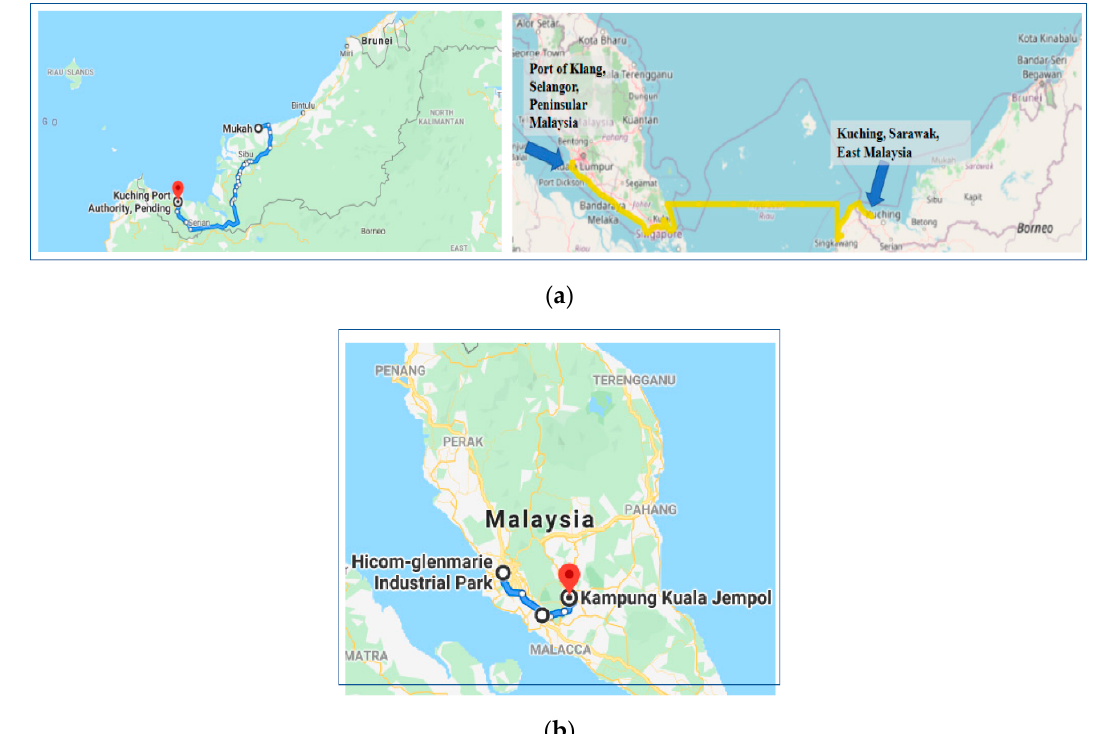
Figure 3. Transportation of raw materials to biocomposite manufacturing gate: ( a ) routes travelled for sago starch: Mukah-Kuching-Klang-Shah Alam and ( b ) route travelled for SPF (Kampung Kuala Jempol-Shah Alam; sources: google maps.com and ports.com).